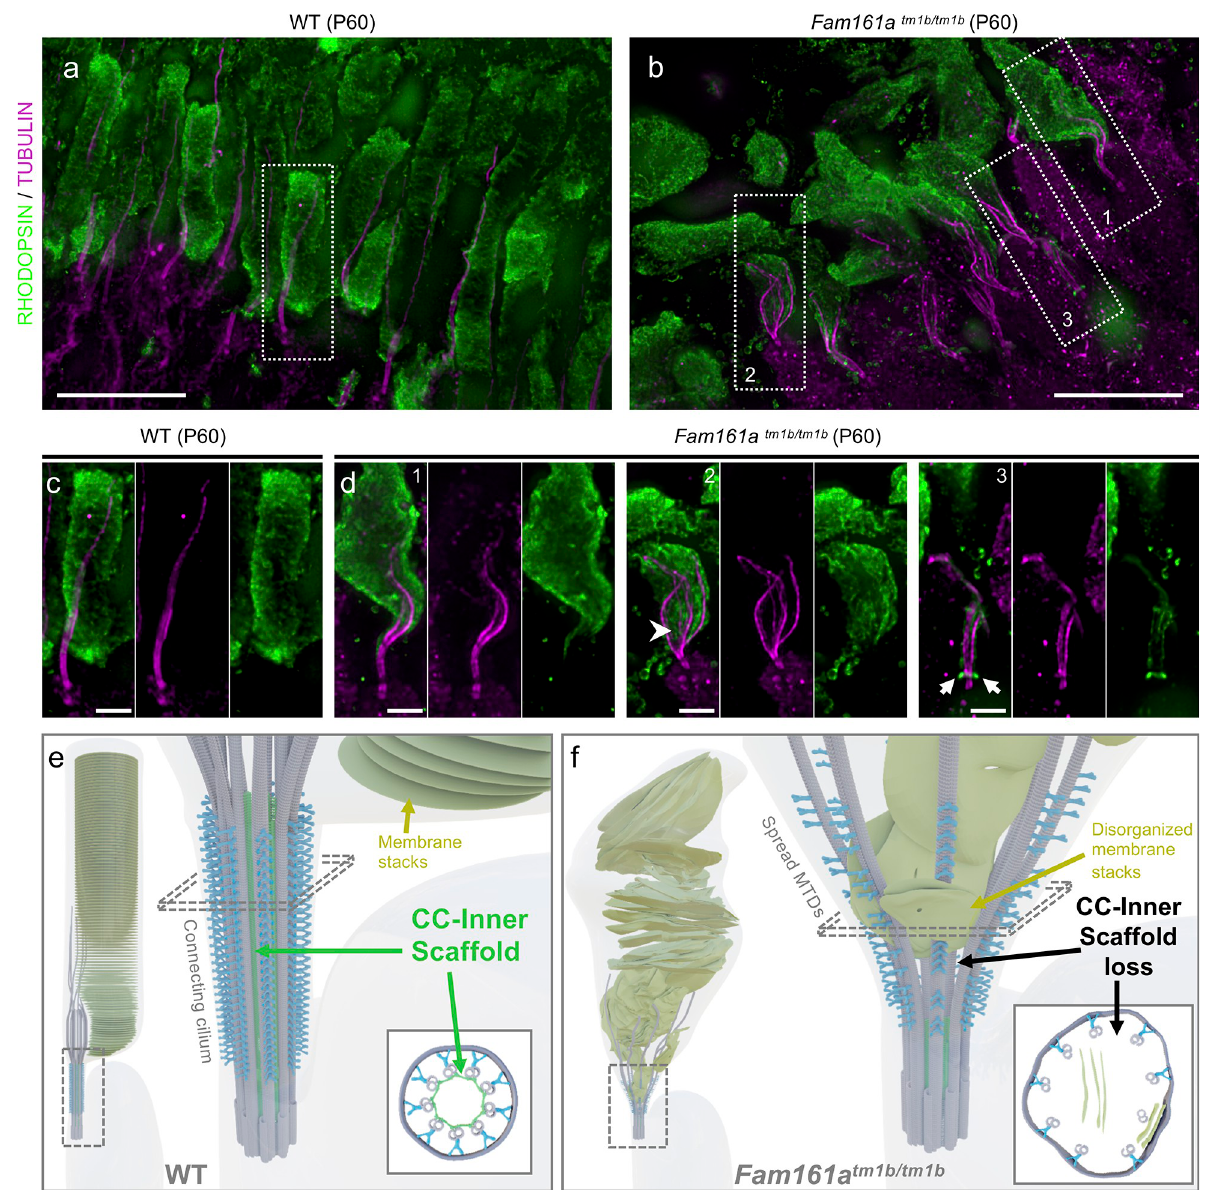
Fig 5. Loss of the CC inner scaffold causes photoreceptor degeneration. ( a, b ) Low magnification of expanded WT (a) or Fam161a tm1b/tm1b (b) retinas stained for RHODOPSIN (green) and tubulin (magenta) at P60. Note the microtubule defects in the mutant, accompanied by outer segment collapse. Dashed lines represent the insets (1, 2, and 3) depicted in (c) and (d). Scale bar: 5 μ m. ( c, d ) Insets from WT (c) or Fam161a tm1b/tm1b (d) retinas depicted in (a) and (b), respectively. Arrowhead shows the RHODOPSIN signal entering inside the microtubules. Arrows depict the accumulation of the RHODOPSIN at the base of the CC. Scale bar: 1 μ m. ( e, f ) Model representing mature WT (e) or Fam161a tm1b/tm1b (f) photoreceptor with the CC region highlighted. Schemes representing transversal sections are depicted in the bottom right of each panel. CC, connecting cilium; WT, wild